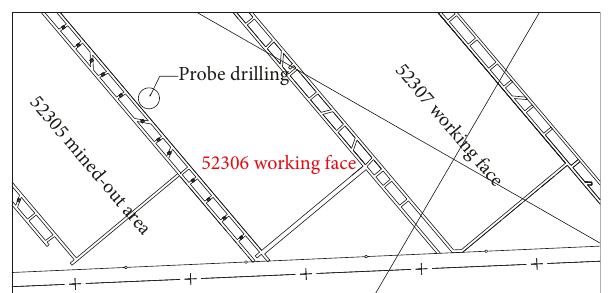
Figure 1: Working surface layout.